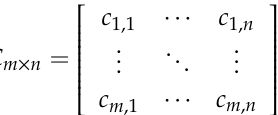
| d − d 0 | ≤ e − | d − d 0 | ≤ H and 0 H